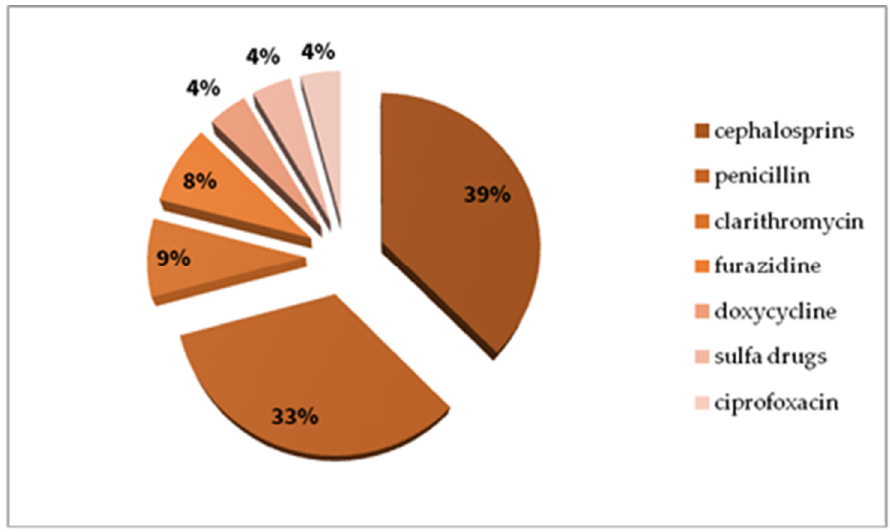
Figure 9. Antibiotic causes of anaphylaxis in the study whole group (%).